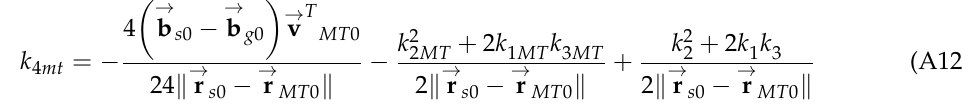
Figure A1. The influence of Target Motion on